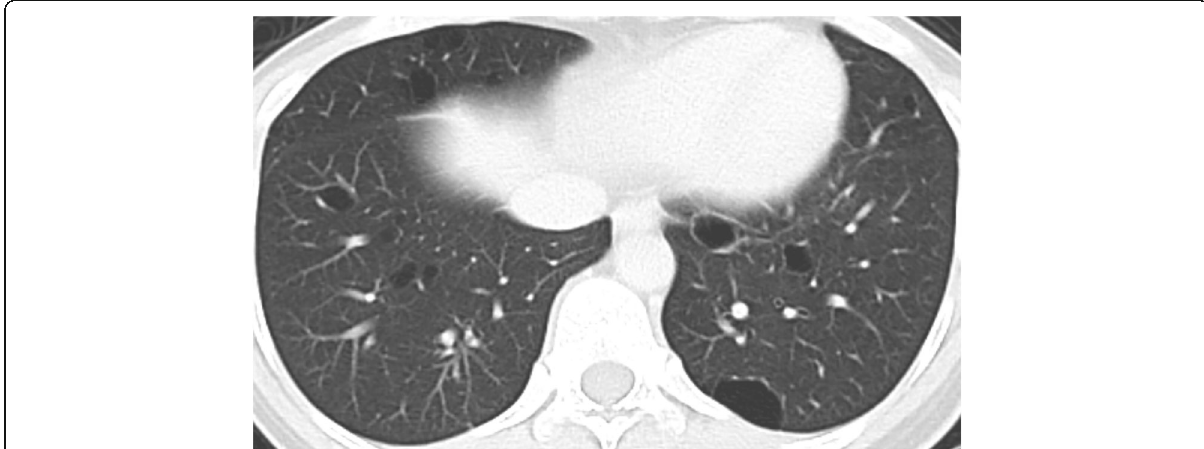
Fig. 2 Computed tomographic scan of the chest showing multiple cysts in both